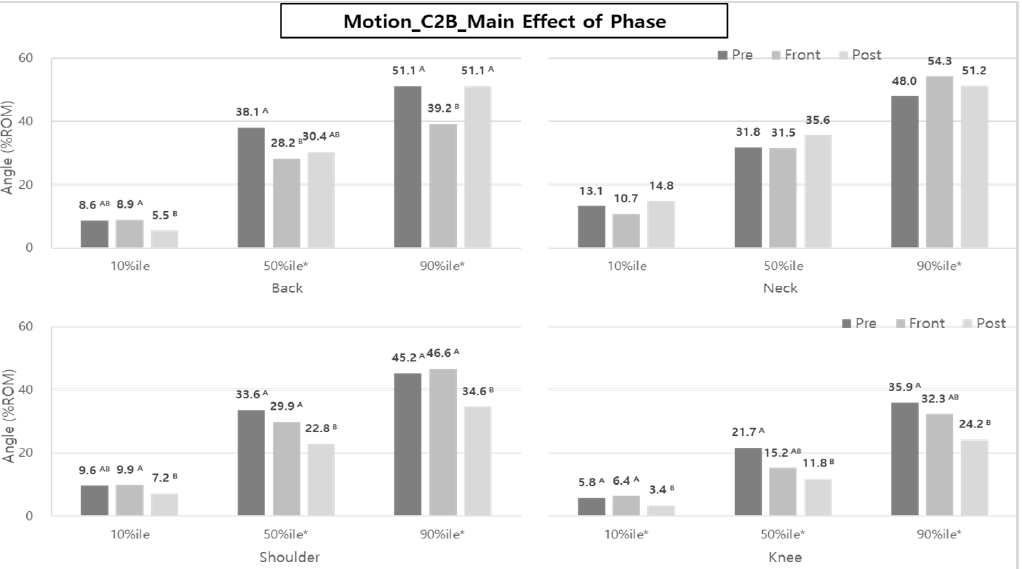
Figure 16. The effect of phase on body posture during C2B. Asterisk (*) and the alphabet capital letter (A and B) indicate that the difference between means is statistically significant at p < 0.05.